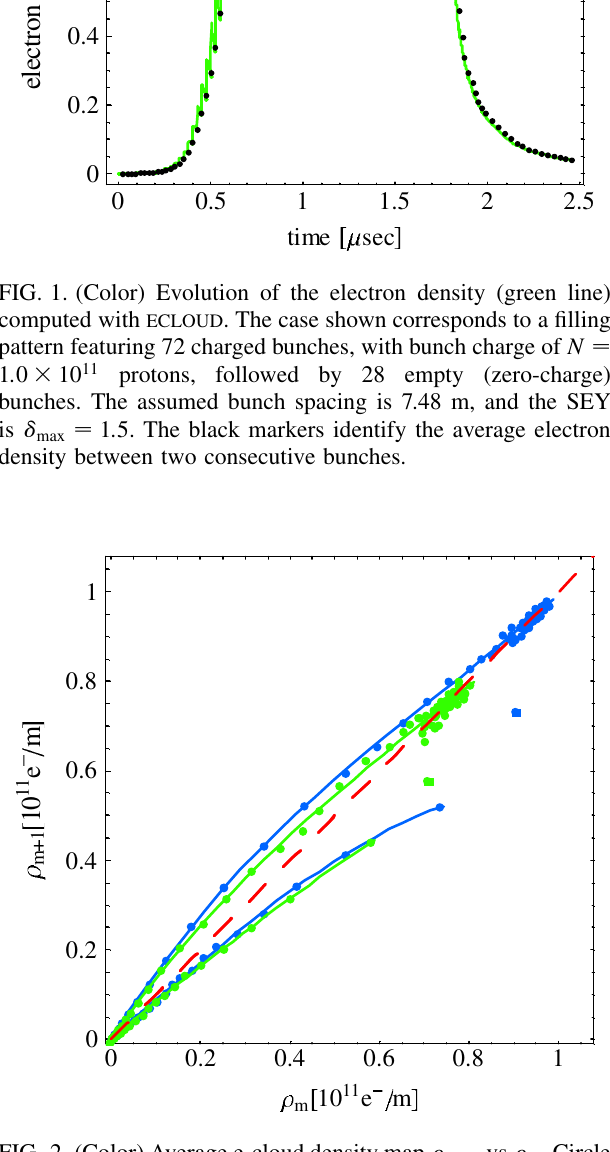
vs (cid:2) . Circle m (cid:4) 1 m (cid:5) 1 : 7 , all other parameters max (cid:5) m (cid:4) 1